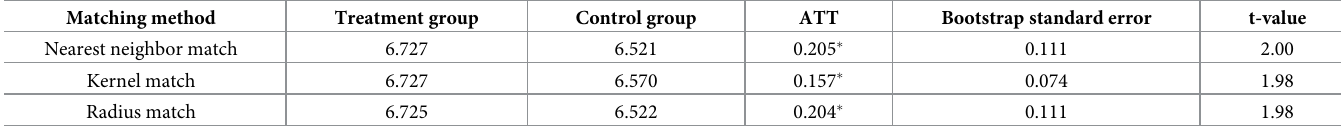
The life satisfaction effect of political participation may vary among urban residents. Drawing on Pirralha [56], this study further analyzed the impact of political participation on urban resi- dents’ life satisfaction under different factors such as education and political identity. Table 5. Mean treatment effect of treatment